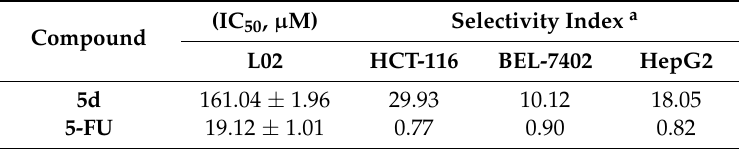
Table 3. In vitro antiproliferative activities of compound 5d against normal cell line